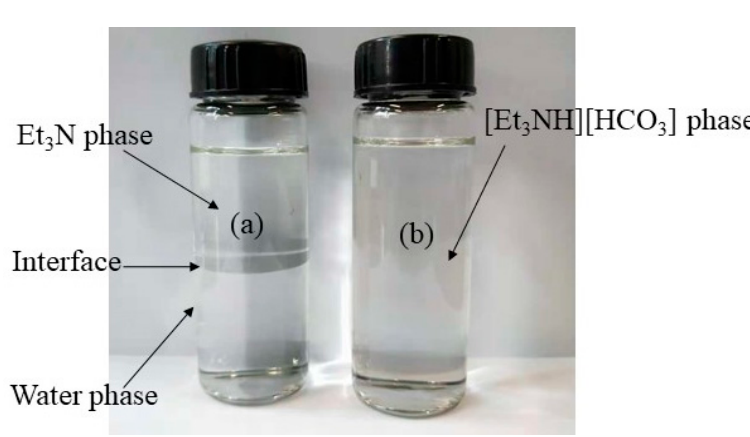
Figure 2. ( a ) The Et 3 N oil phase and water phase coexist in the trimethylamine-water system with an interface between them; ( b ) one homogenous phase appears in the SHT solution after CO 2 addition.